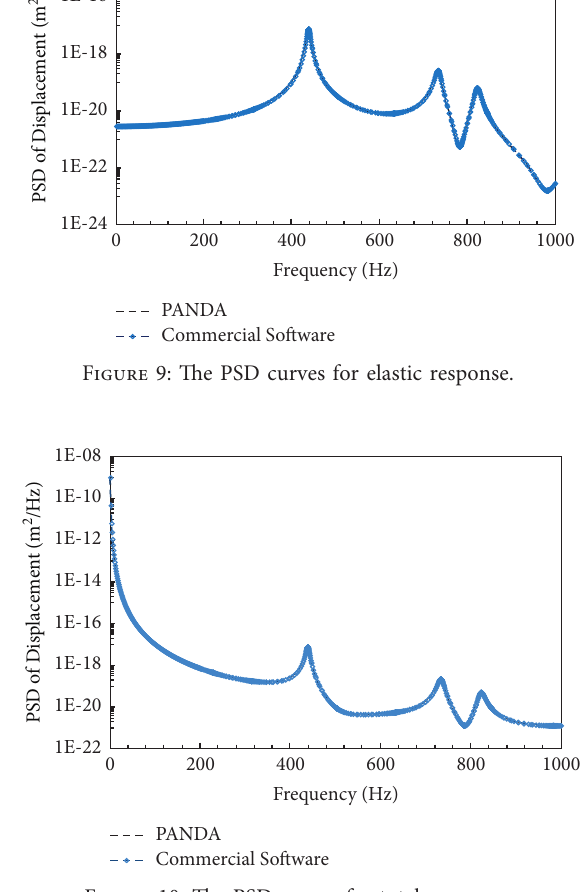
Figure 10: The PSD curves for total